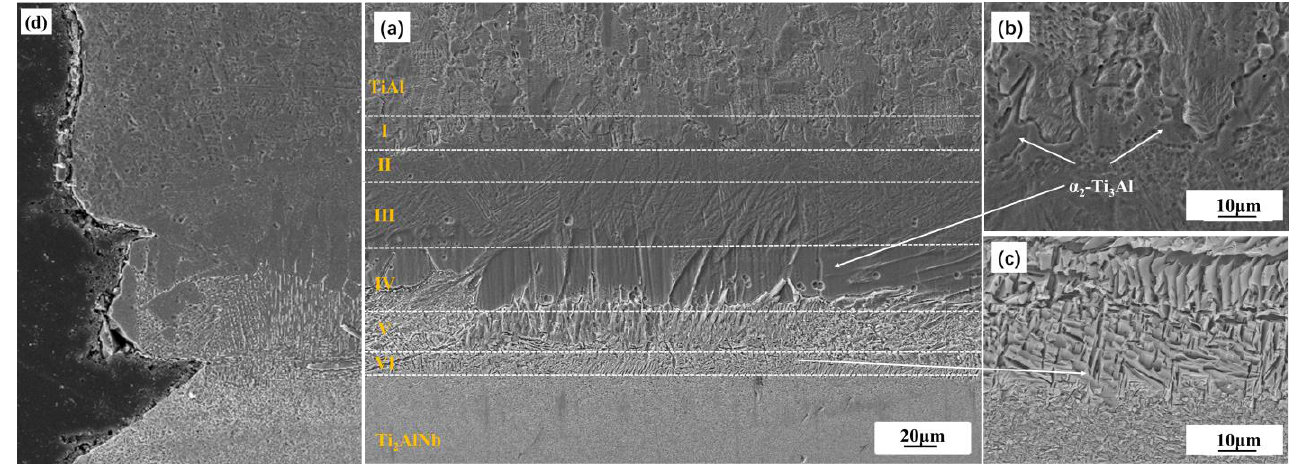
Figure 5. Microstructure of the PWHT joint:( a ) SEM image of the joint; ( b ) enlarged image of Zone Ⅳ ; ( c ) enlarged image of Zone Ⅵ ; ( d ) cross-section image of the fracture.